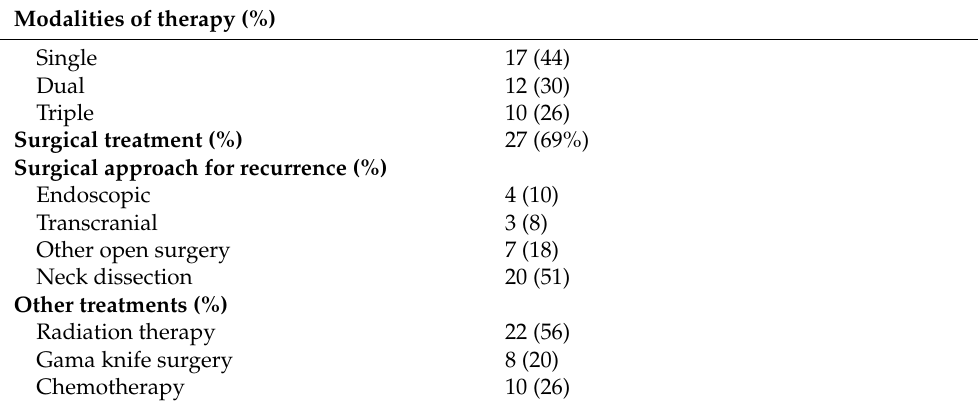
Table 5. Salvage therapy (n = 39).